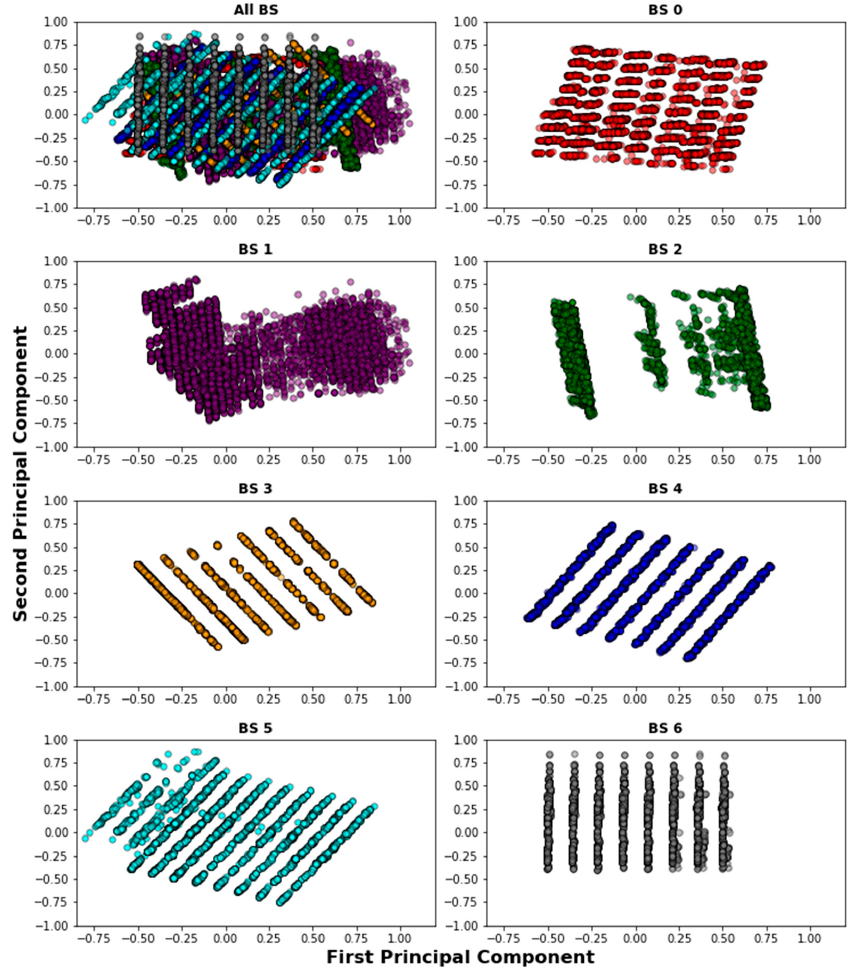
Figure 6. Discovered patterns for BS after projecting the first two principal components.